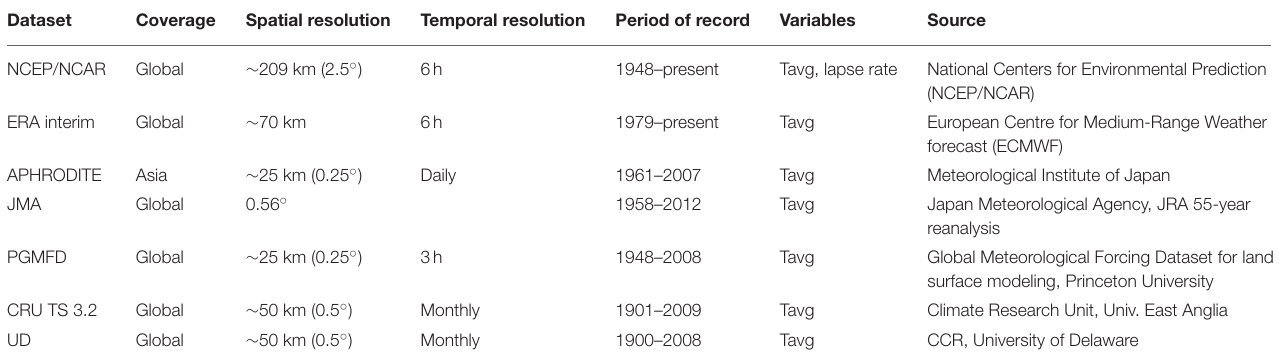
TABLE 1 | Overview of the gridded reanalysis climate datasets compared in this